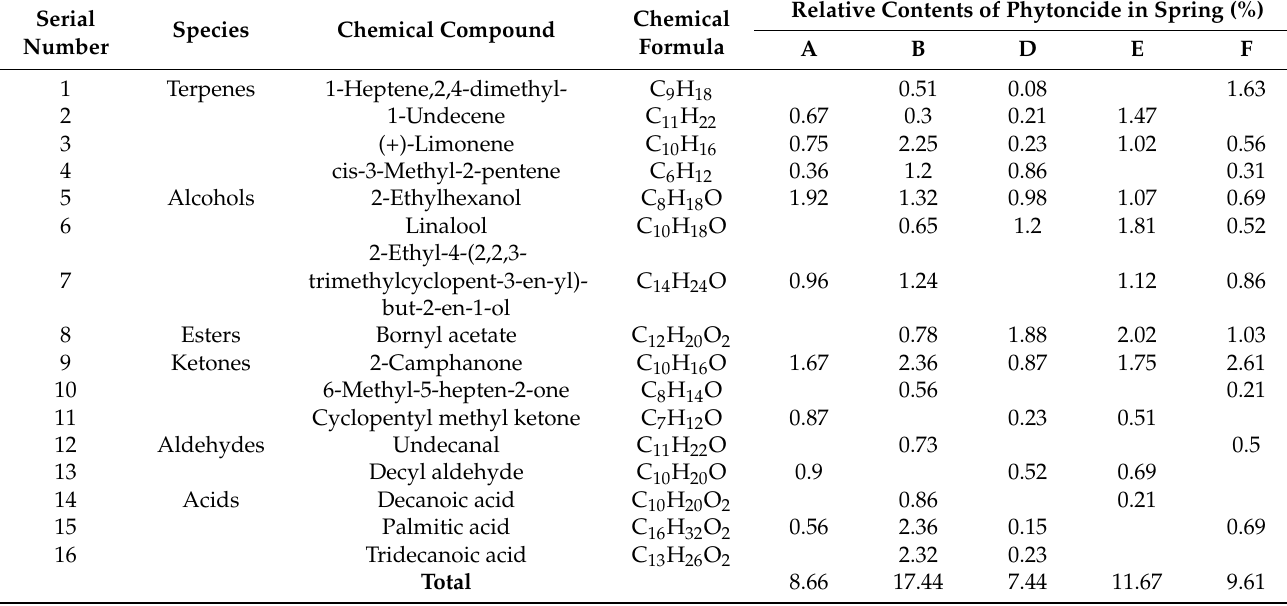
Table 4. Relative content of phytoncide